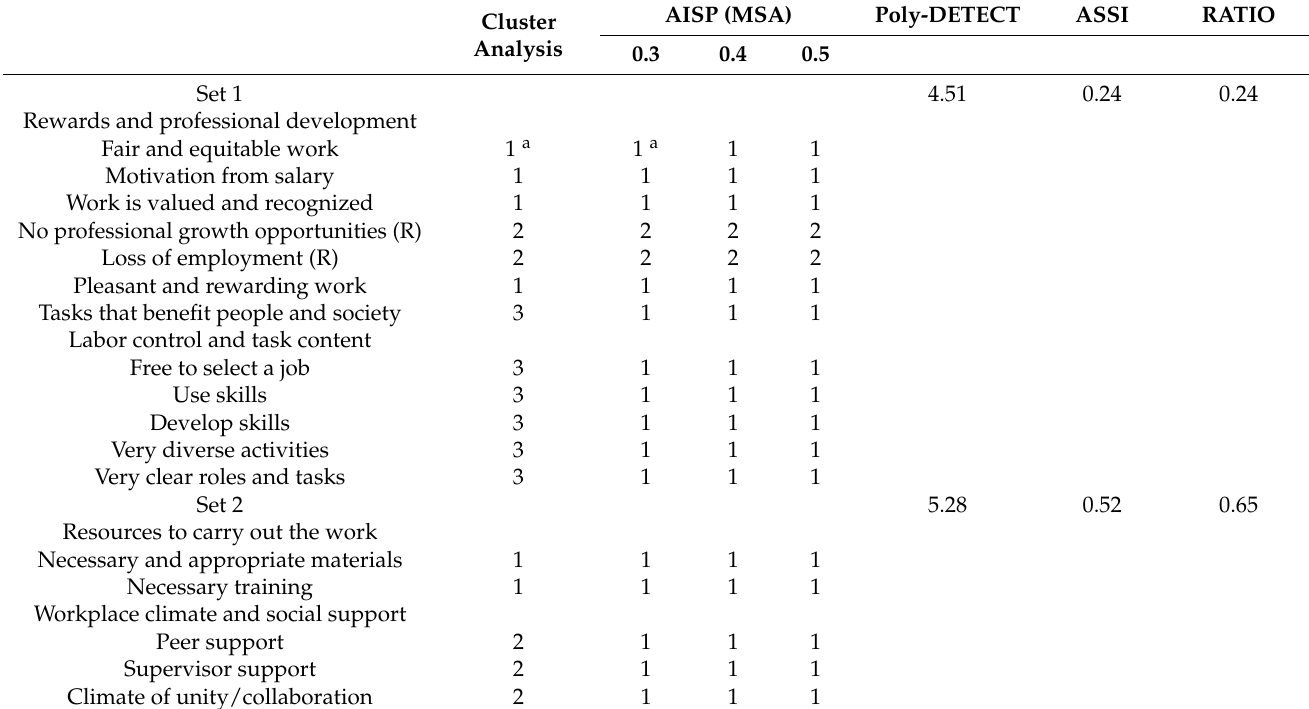
Table 3. Nonparametric assessment: positive psychosocial resource factor